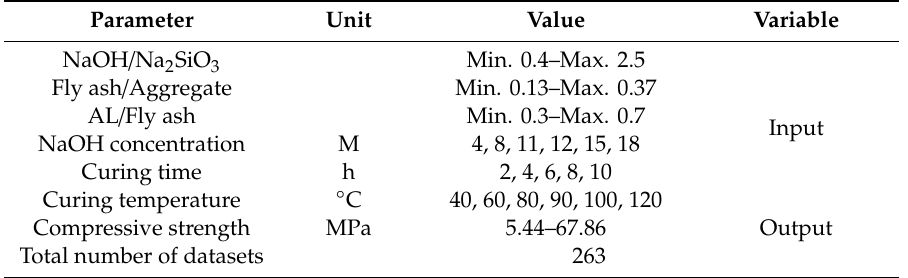
Table 2. Statistical parameters of fly ash-based geopolymer (FAGP) concrete used in the training